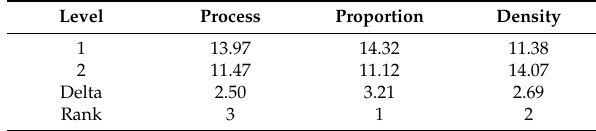
Table 6. Ranking of input process parameters for electrical conductivity.